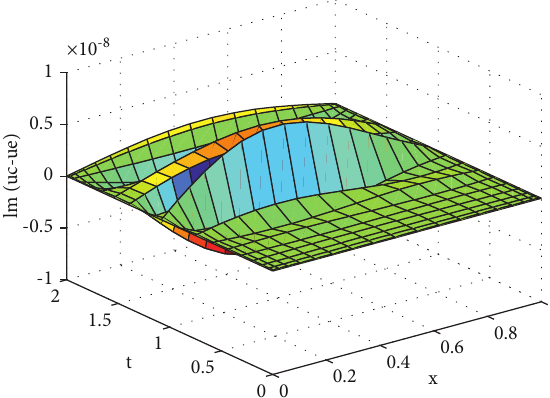
Figure 2: Error estimate of quasi-equidistant nodes with t � 2 , m � n � 19 , and d Table 5: Convergence rate of equidistant nodes with different d